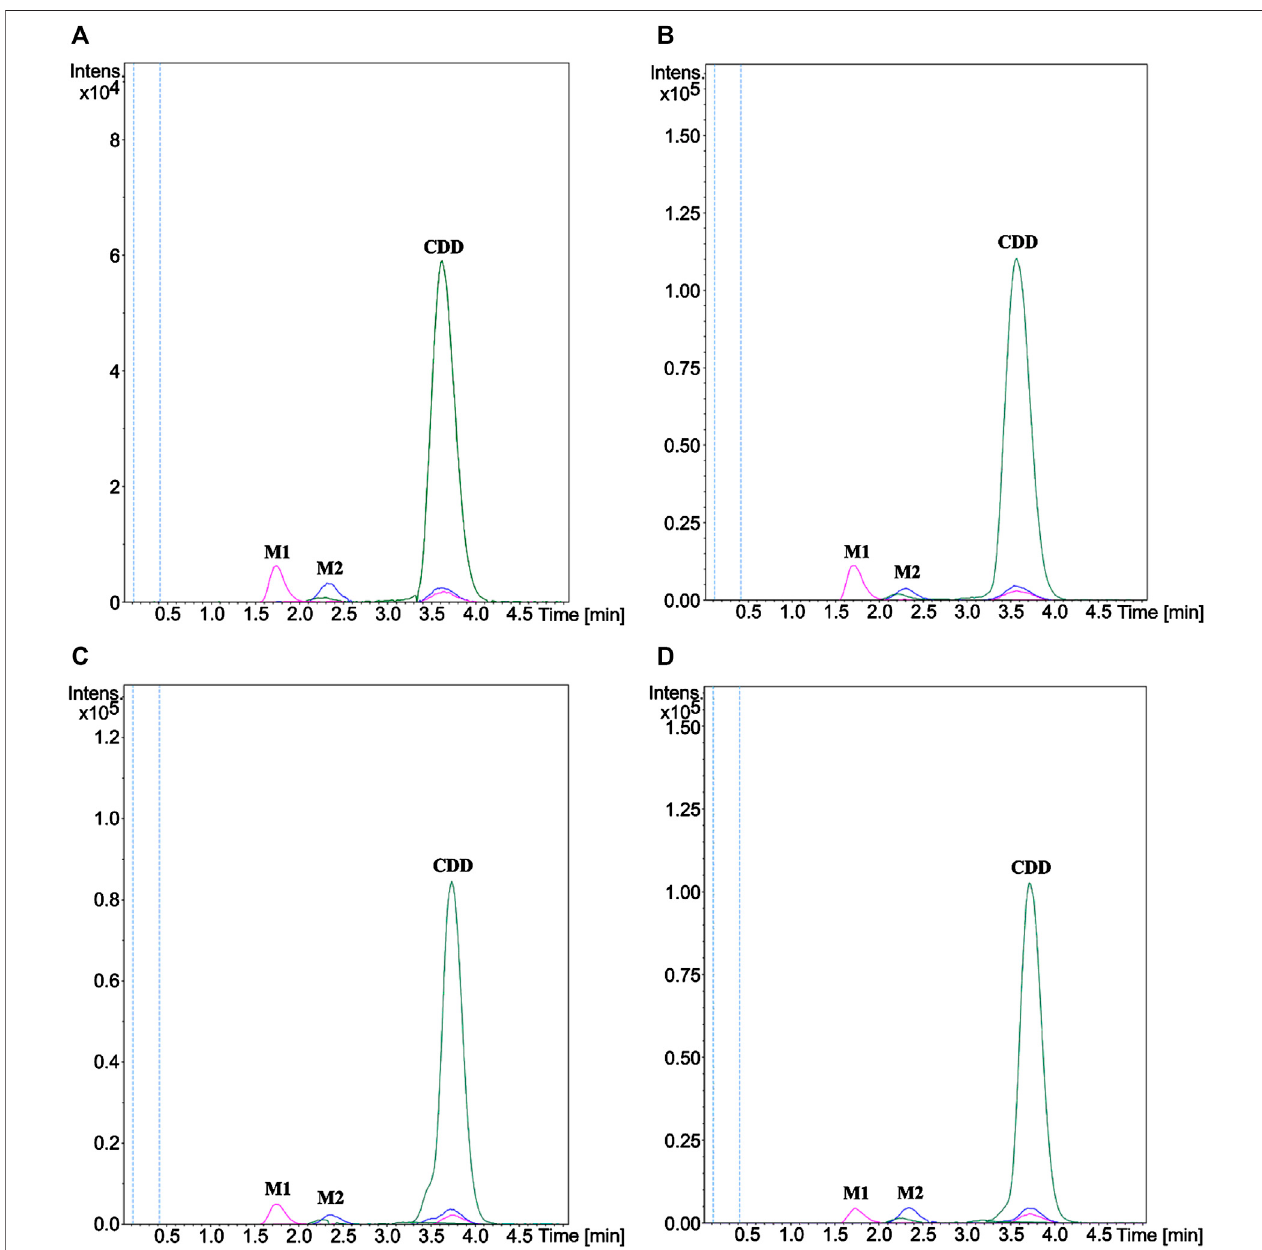
FIGURE2| Extracted ionchromatogramsofCDDand its metabolitesM1 and M2in (A) HLS9, (B) MLS9, (C) DLS9,and (D) RLS9. CDD (10 µM)wasincubated in HLS9, MLS9, DLS9, and RLS9 (1 mg/ml) at 37 ° C for 0.5 min.